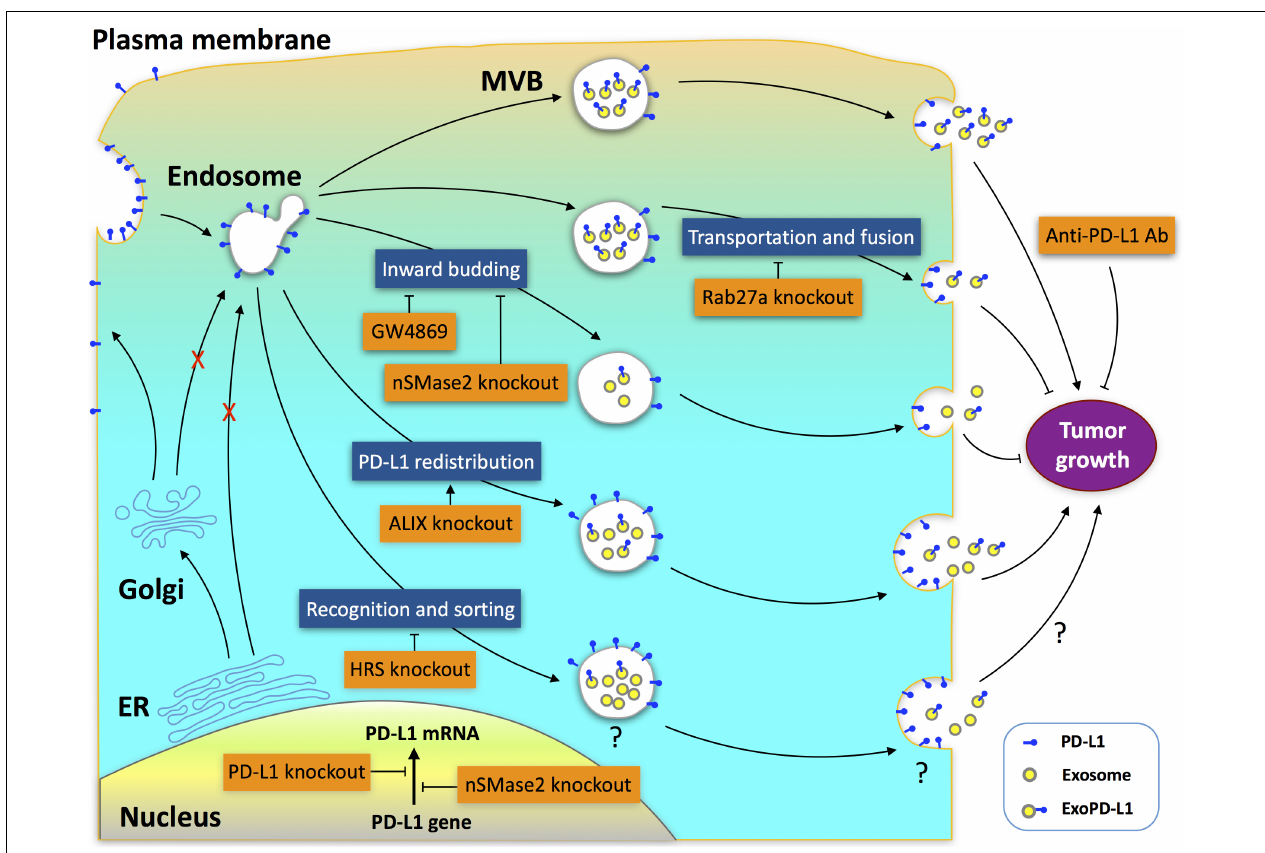
FIGURE 2 | Potential targets for antitumor therapy in ExoPD-L1 biogenesis pathways. Multiple molecules, including Rab27a, nSMase2, ALIX, and HRS, participate in the complex processes of ExoPD-L1 biogenesis, which originates from the cell surface rather than from the ER or Golgi apparatus. Deletion of Rab27a decreases ExoPD-L1, but does not alter cell-surface PD-L1 levels. Deletion of nSMase2 reduces the levels of both cellular PD-L1 and ExoPD-L1 protein. Rab27a deletion causes a greater inhibition in exosome production compared with nSMase2 deletion, while nSMase2 deletion leads to a greater inhibition of ExoPD-L1 production compared with Rab27a deletion. GW4869, an inhibitor of nSMase2, inhibits ExoPD-L1 generation, but does not increase cellular PD-L1 levels. Knockdown of ALIX, which redistributes PD-L1 between the cell-surface and exosomes, results in a reduction of ExoPD-L1 production but an increase in cell-surface PD-L1. Blockade of Rab27a or nSMase2 results in suppression, whereas ALIX knockdown promotes tumor growth. Knockdown of HRS, an ESCRT-0 subunit, confers a decrease in ExoPD-L1 levels but an increase in cellular PD-L1 levels. The effects of HRS knockdown on the cell-surface PD-L1 levels and tumor growth remain unknown.